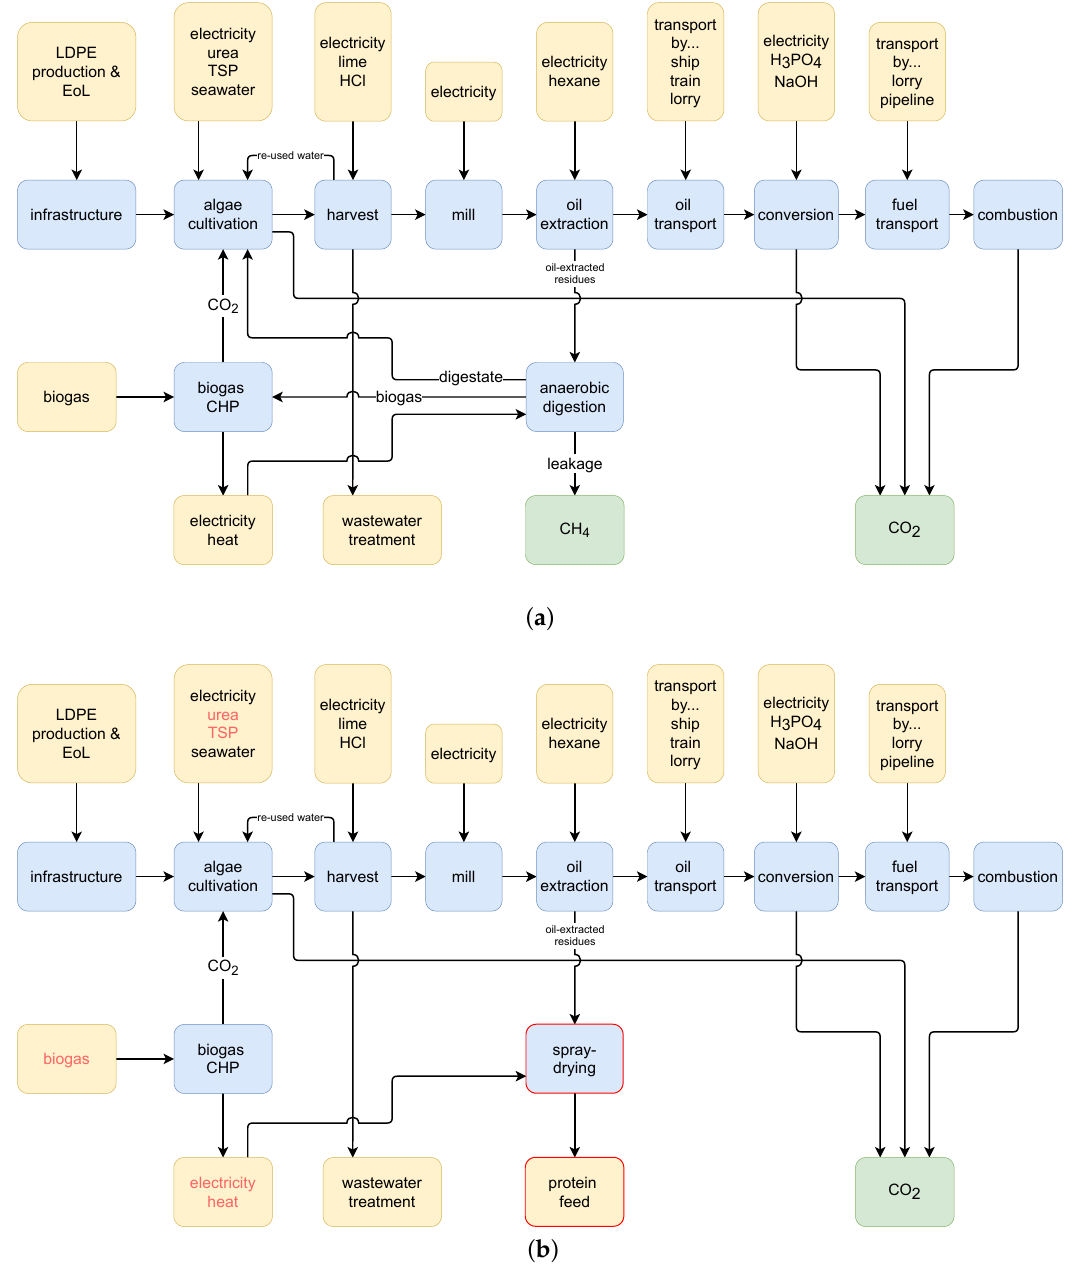
Figure 1. Scheme of the two studied algal fuel co-production systems. Yellow—background system; green—biosphere; blue—foreground system; red frame—process newly introduced in AF + fodder system; red font—identical process in both systems but with different flow amount. Abbreviations: LDPE—low density polyethylene; EoL—end of life; TSP—triple superphosphate; CHP—combined heat and power plant. ( a ) AF + energy system (adapted from [31]). ( b ) AF + fodder